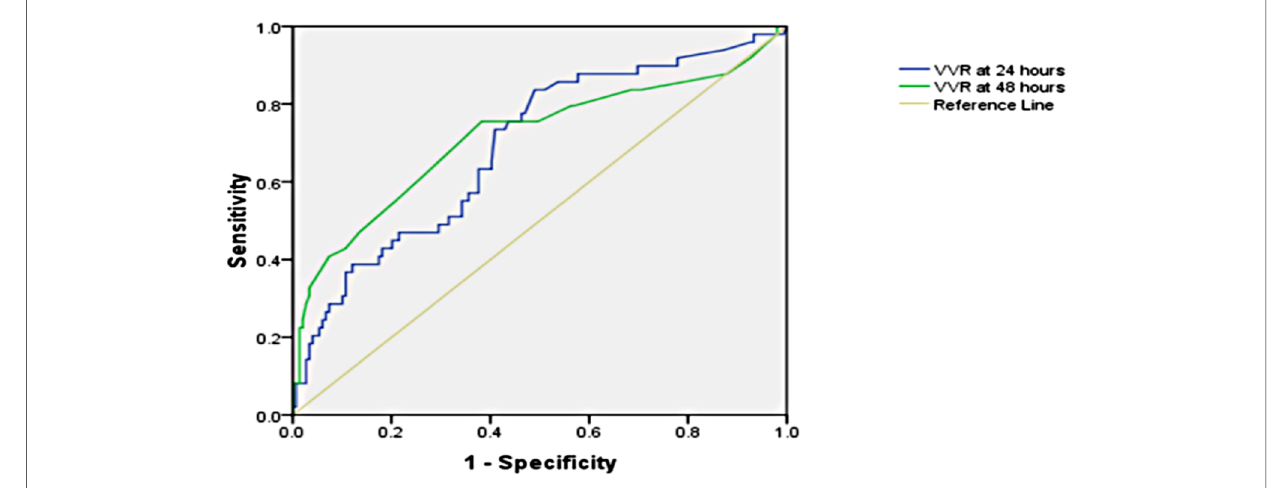
FIGURE 1 Receiver operating characteristic curve for the prolonged PICU stay and vasoactive-ventilation-renal score at 24 h and 48 h